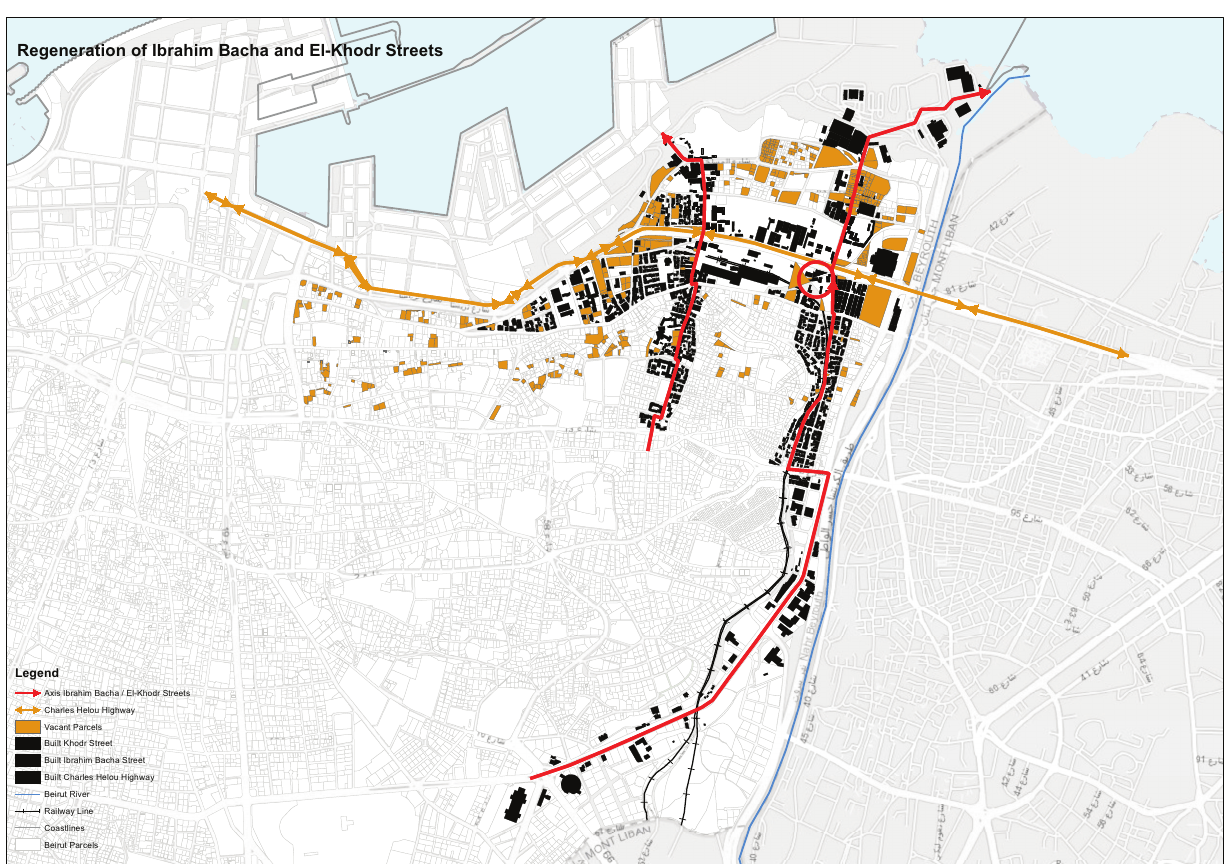
Figure 3. BUD: Axe 3. The regeneration of Ibrahim Bacha and El‐Khodr Streets is represented in red. Source: Author’s work based on the Order of Engineers and Architects